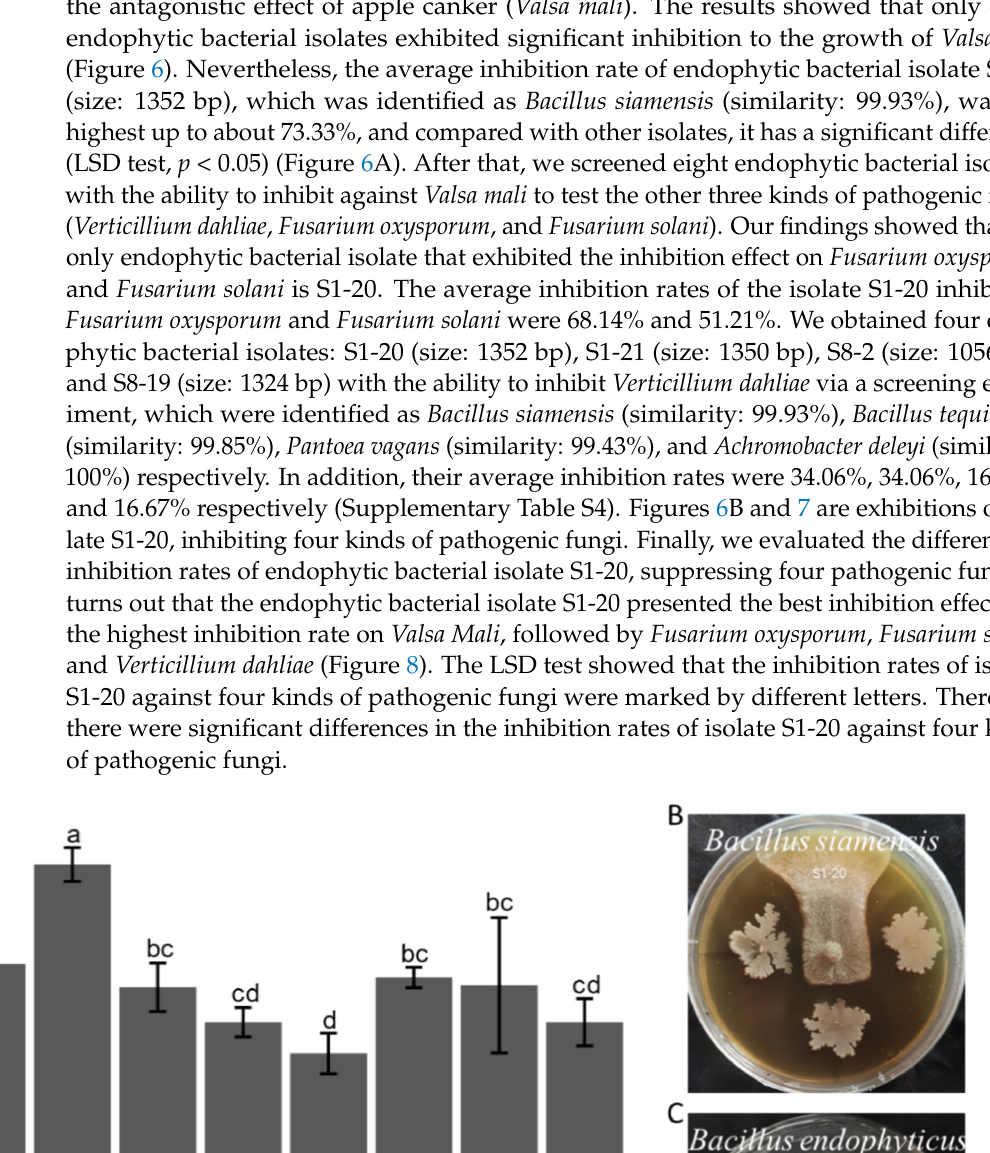
Figure 7. Exhibition of antagonistic effects of endophytic bacterial isolate S1-20 against pathogenic fungi (( A ): Verticillium dahliae , ( B ): Fusarium oxysporum , and ( C ): Fusarium solani ).